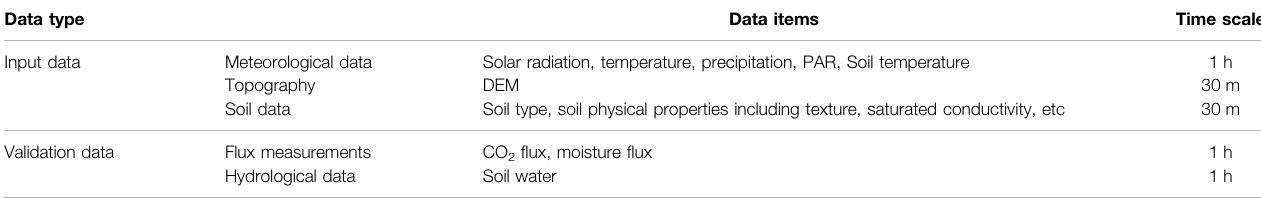
TABLE 1 | Data used in this